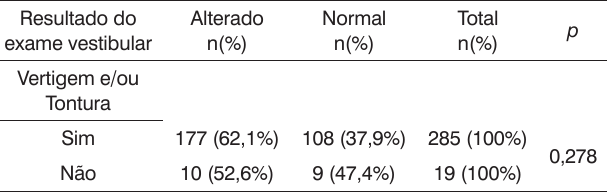
Tabela 4. Associação entre resultado do exame vestibular e pre- sença de vertigem/tontura na amostra (Teste Qui-Quadrado).